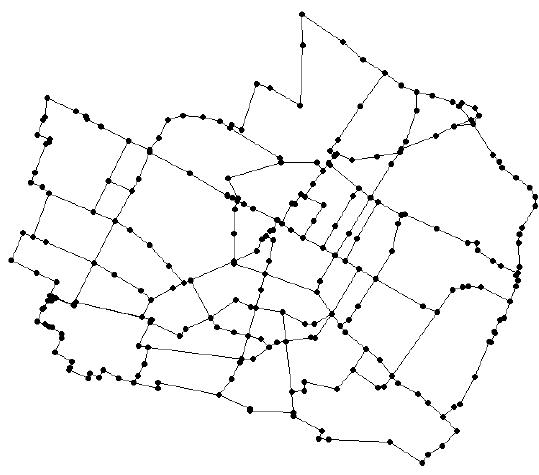
Figure 2. Layout of Modena network.